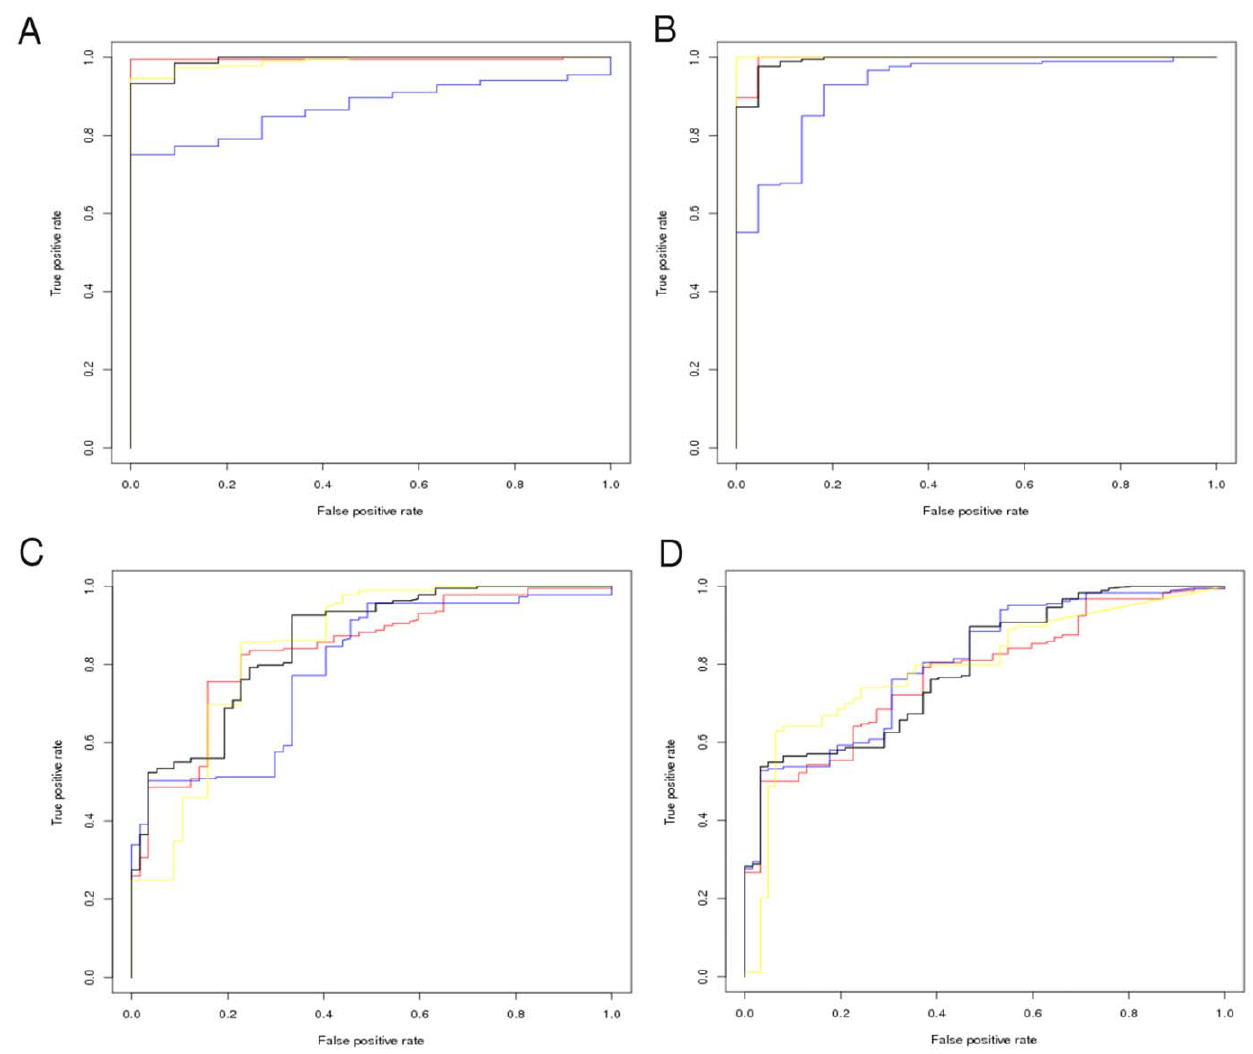
Figure 2. Receiver Operator Characteristic curves for the top single score and each combination method plots. ROC plots for the top single component score (Equivalent Residue Ligand Distances) (black), the Linear Combination (red), Multiple Linear Regression (blue) and Neural Network (yellow) scores for both the MCC and BDT performance metrics on both the CASP8 and CASP9 datasets at a true positive rate of 0.5. A) ROC plot for the MCC performance metric on the CASP8 dataset. B) ROC plot for the BDT performance metric on the CASP8 dataset. C) ROC plot for the MCC performance metric on the CASP9 dataset. D) ROC plot for the BDT performance metric on the CASP9 dataset.